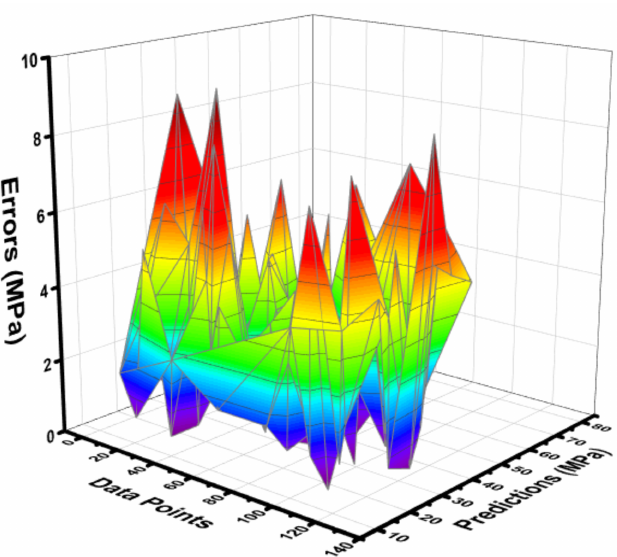
Figure 12. Difference between the experimental C-S and predicted C-S of the BR model.